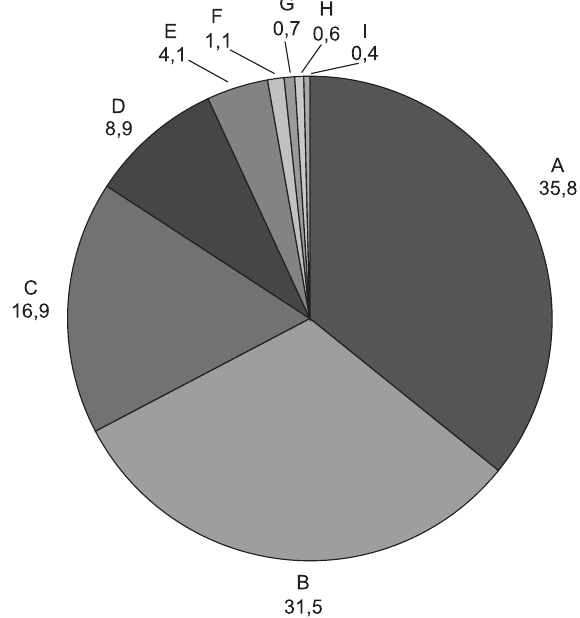
Fig. 12. Structure of organic crops in Poland, 2014 (%).